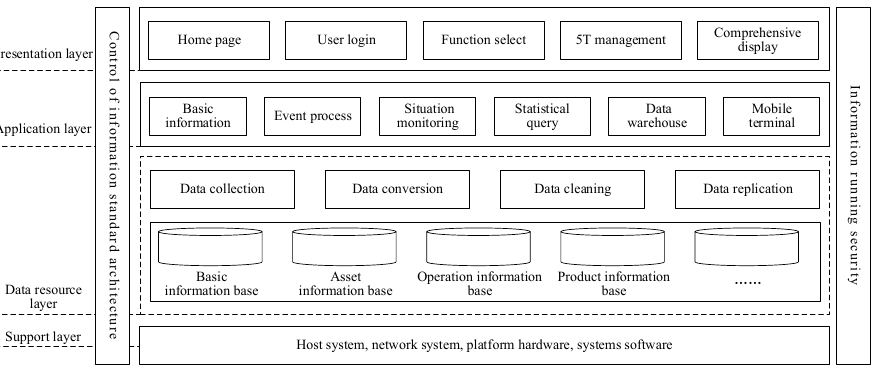
Figure 11. The system architecture of Agricultural Production Data Management System [76].